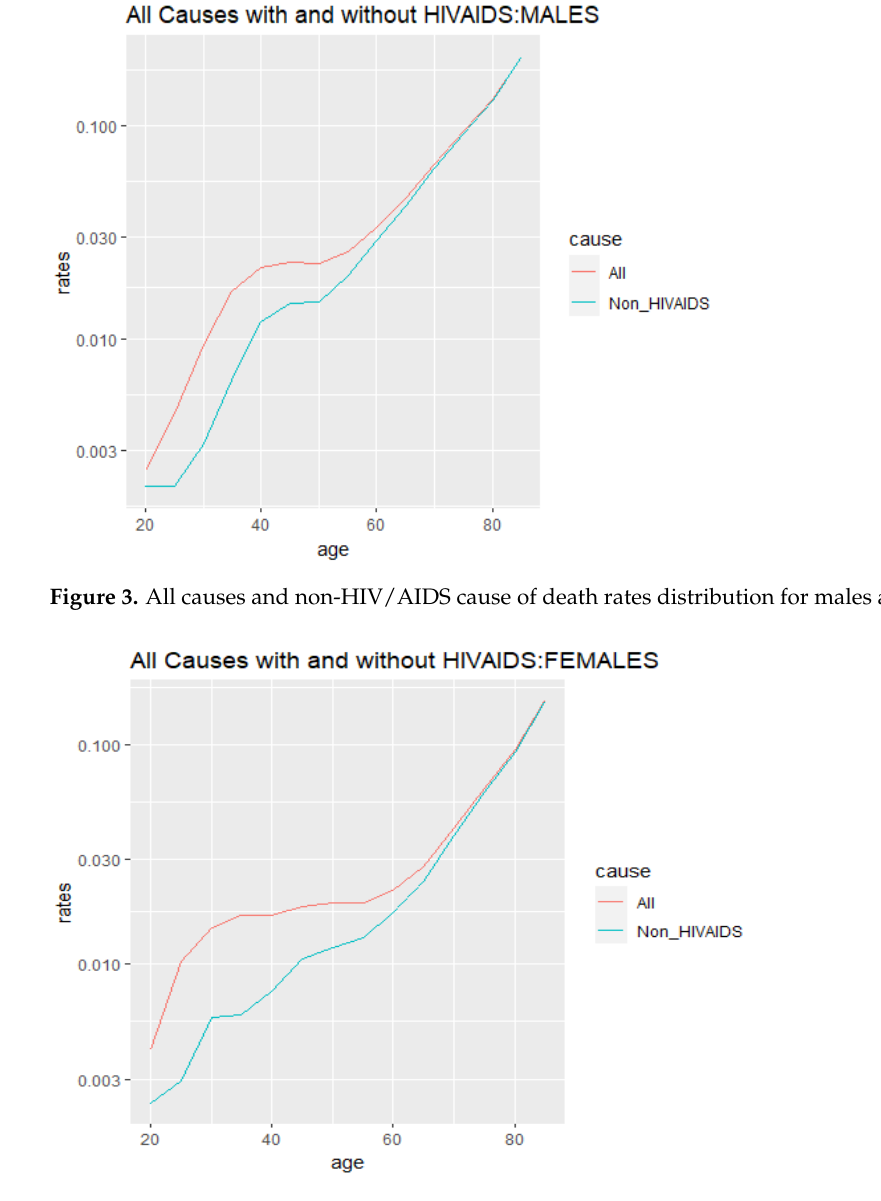
Figure 4. All causes and non-HIV/AIDS cause of death rates distribution for females against age.